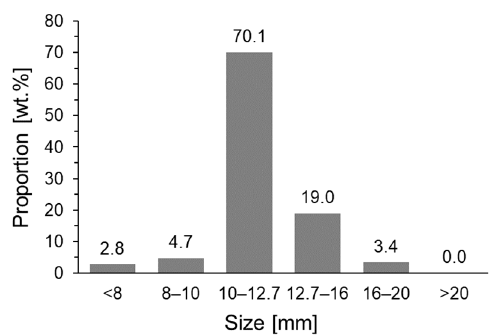
Figure 1. Size distribution of the fired pellets on a weight basis.